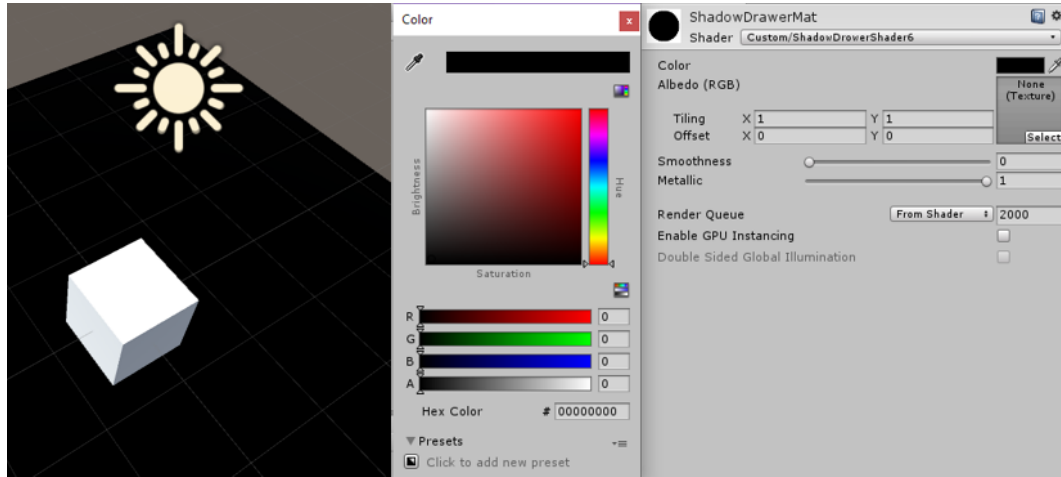
Figure 16. SD with texture color set to “Black”.